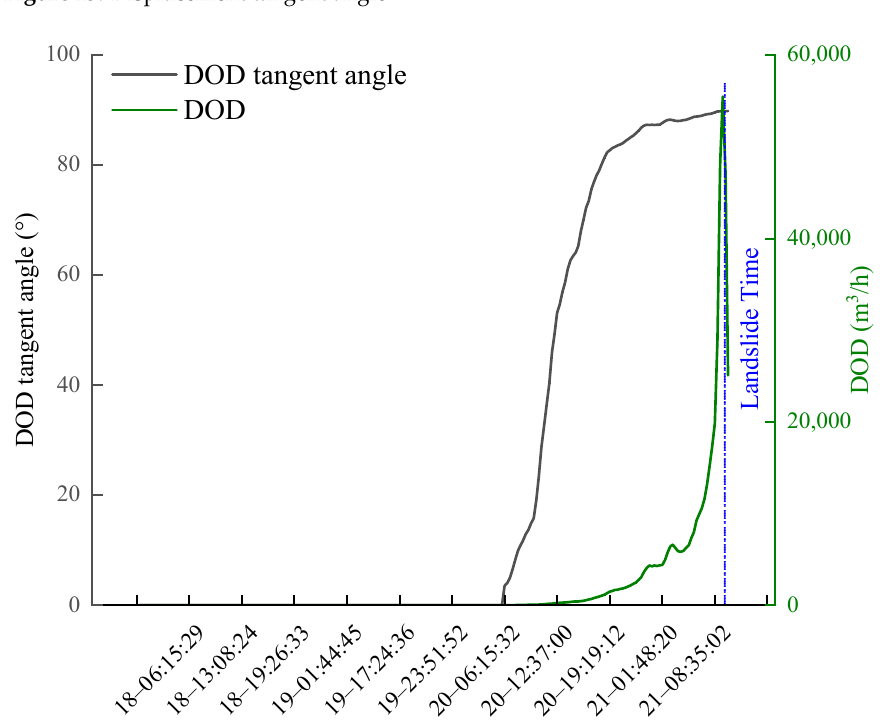
Figure 13. Displacement tangent angle.